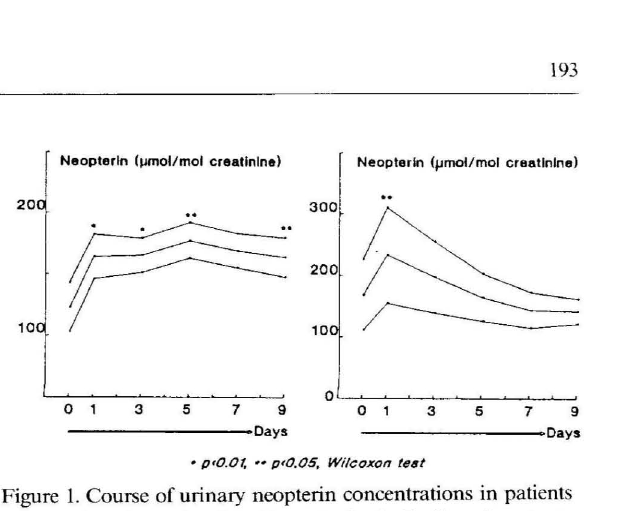
Figure 1. Course of urinary neopterin concentrations in patients before (day 0) and after (days 1, 3, 5, 7, 9) apicoectomy of the front region. Mean (middle line) and mean± S.E.M. (upper and lower lines) of absolute neopterin concentations is shown.